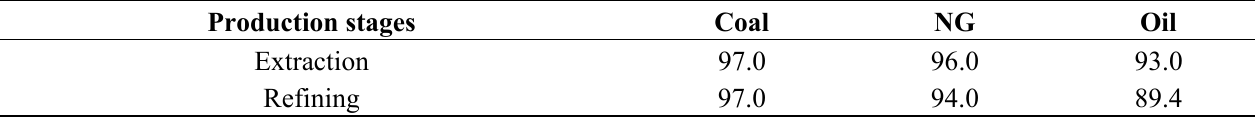
Table 2. Energy conversion efficiencies during the fuels’ extraction and refinery stage (%)